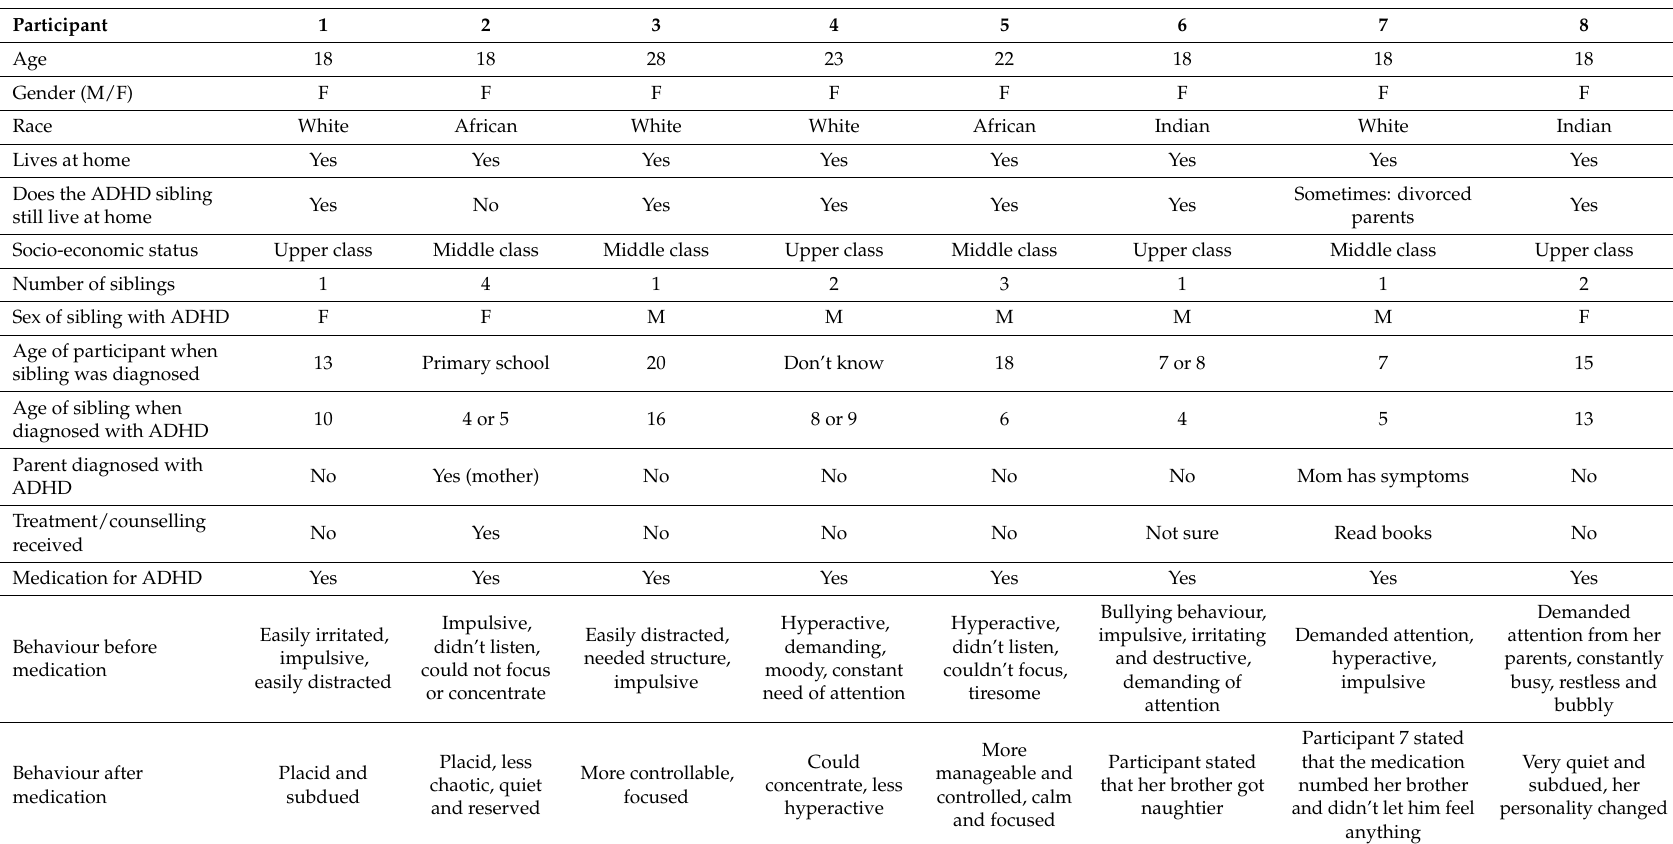
Table 1. Participants’ socio-demographic